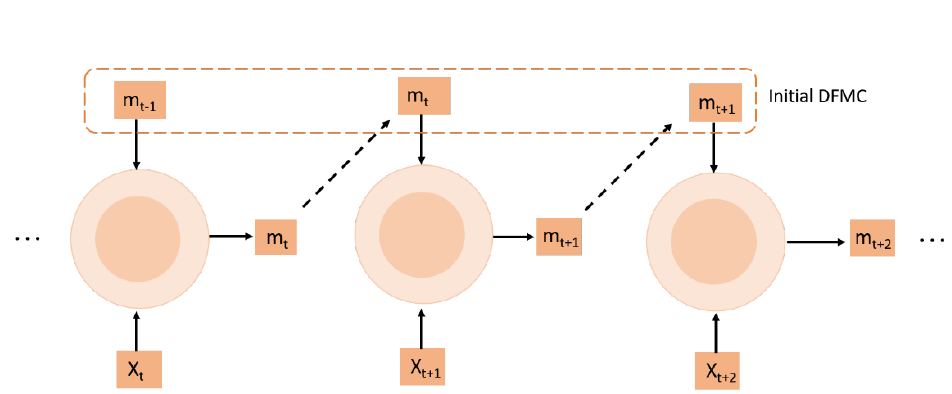
Figure 3. The operation process of FSMM model. Where m is DFMC, m t–1 is m at time t–1. X refers to the input drivers, which were shown in Table 1.